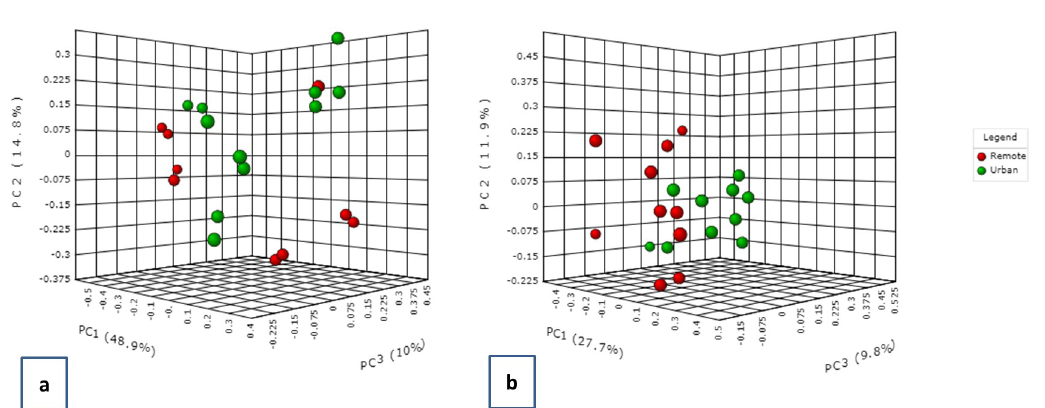
Fig 4. Beta diversity clustering based on PCoA on the Bray Curtis distances of (a) bacterial genus and (b) fungal genus distributed between two locations in Kuwait. The two colours represent the two sites Abdally/remote and Kuwait city/urban.